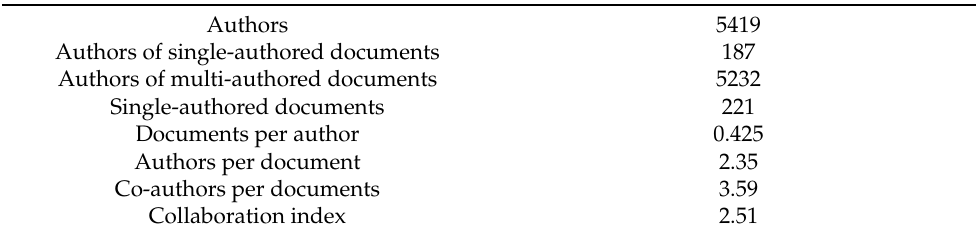
Table 2. Authors contributing to the OSM